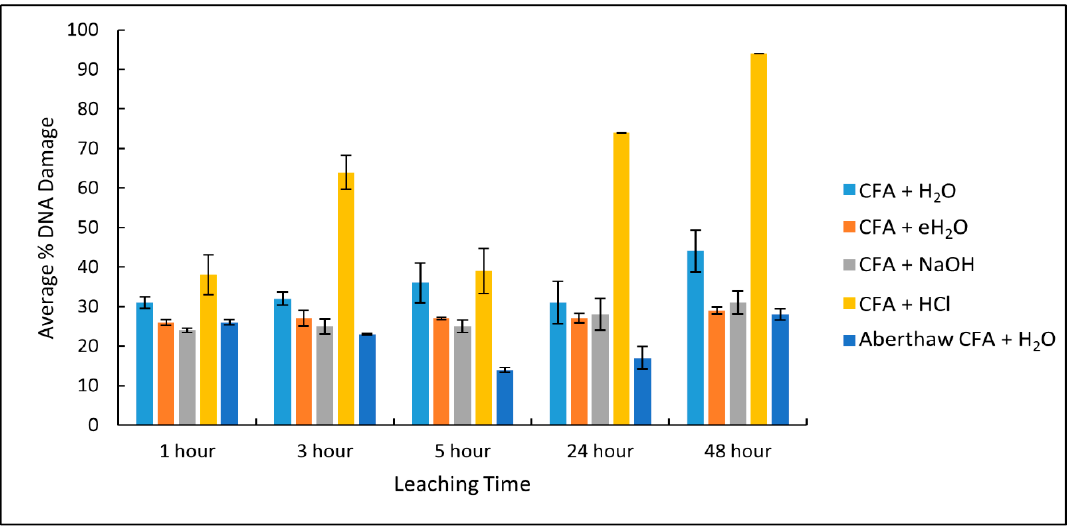
Figure 4. Damage caused to plasmid DNA by five different PM 2.5 CFA leachates at 2000 µg/mL. The only significant increase ( p < 0.05) in damage over the leaching period came from the CFA and H 2 O leachate (48 h) and the CFA and HCl leachates (3, 24, and 48 h). All results are minus the negative control (the leaching condition, e.g., HCl) and the mean ( n = 4) result shown. Error bars display standard deviation (SD).